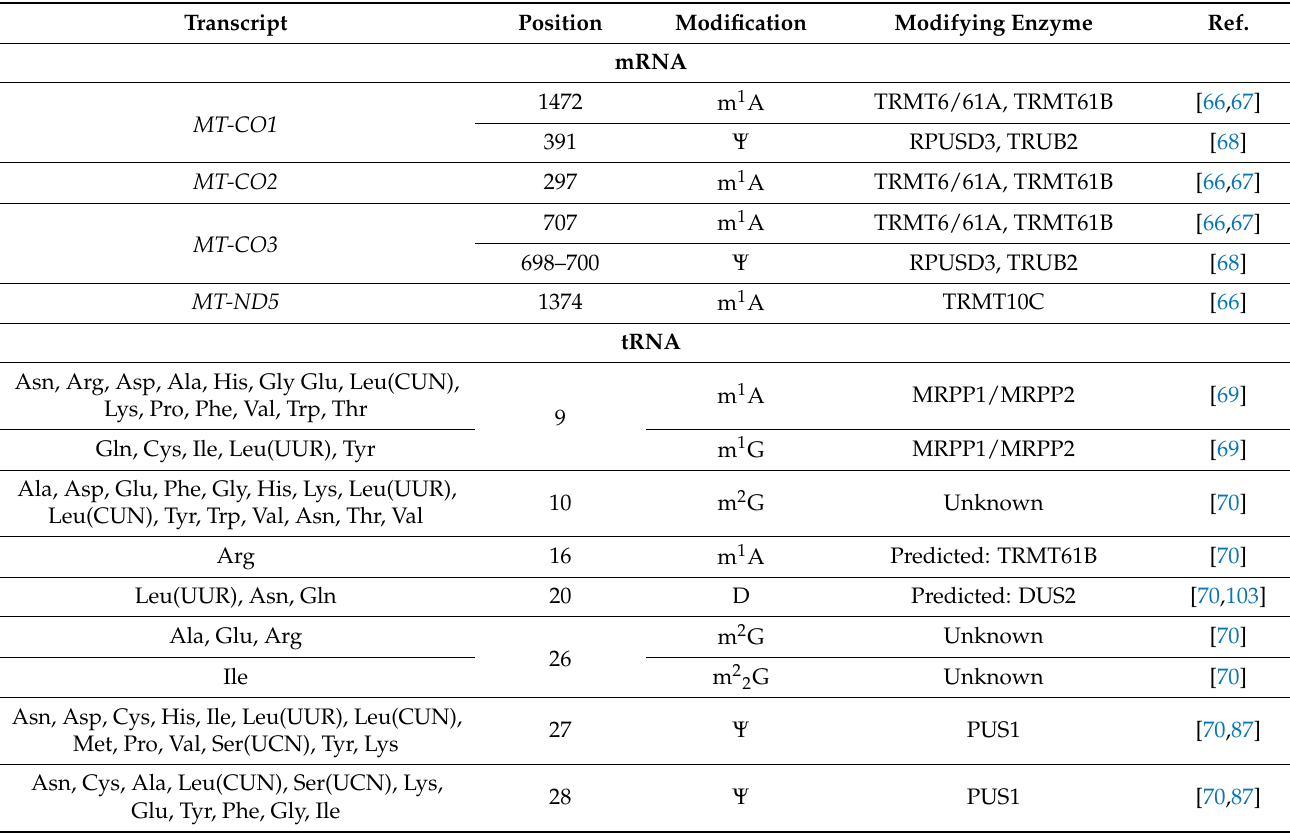
Table 1. Post-transcriptional modifications of mtRNAs in human mitochondria. f 5 C: 5-Formylcytosine; m 1 A: 1-ethyladenosine; m 1 G: 1-Methylguanosine; m 2 G: N 2 -Methylguanosine; m 2 2 G: N 2 , N 2 -Dimethylguanosine; m 3 C: 3-Methylcytosine; m 4 C: N 4 - Methylcytosine; m 5 C: 5-Methylcytosine; m 6 2 A: N 6 , N 6 -Dimethyladenosine; ms 2 i 6 : 2-Methylthio- N 6